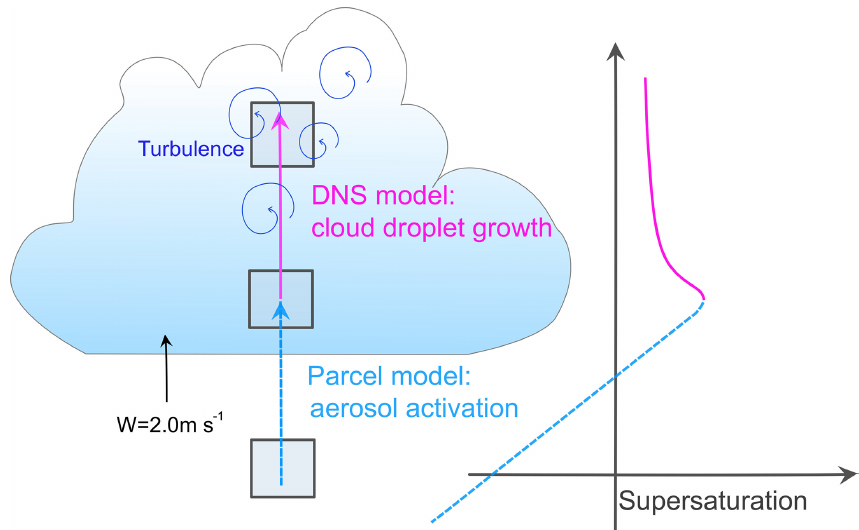
Figure 1. Schematic diagram of the parcel–DNS hybrid model along with the unscaled bulk supersaturation with height. The parcel model simulates the ascending process below the height of maximum supersaturation (dashed blue line), and the DNS simulates the subsequent ascending process (solid violet line).